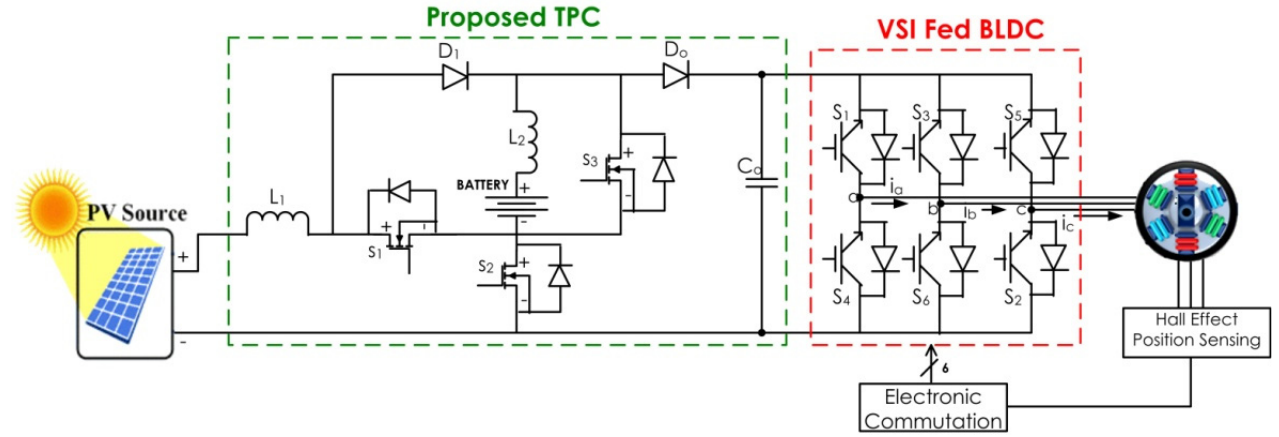
Figure 1. Proposed TPC DC–DC Structure.